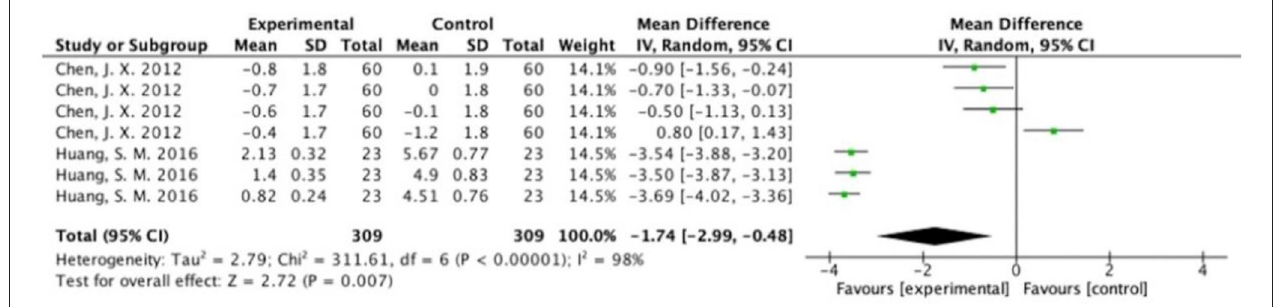
FIGURE 7 | Sub-analysis on the effect of herbal medicine in nausea and vomiting in chemotherapy-induced toxicity.